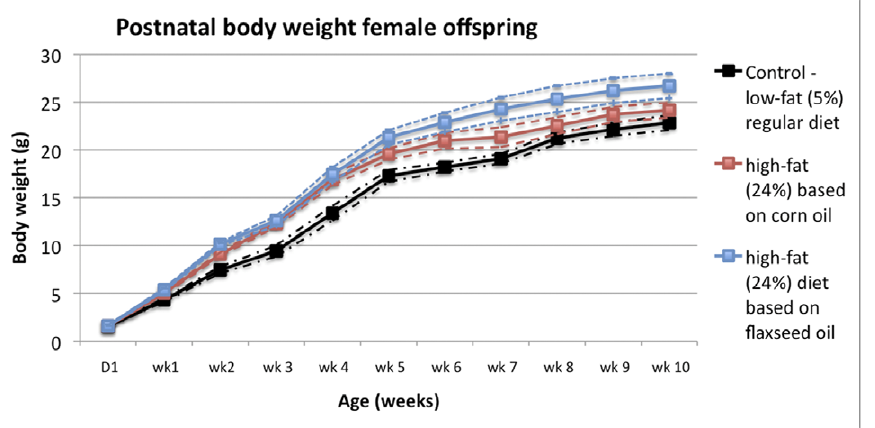
Figure 2. Body weight trajectories in F1 female mice, perinatally exposed to a low-fat (5%) regular mouse diet (indicated in black), or to high-fat (24%) diets based on either corn oil (red) or flaxseed oil (blue). Graph plots mean (and 95% confidence intervals) body weights of F1 female pups with age. The increased body weights of mice fed high-fat diets were significant versus regular diet at 3 weeks of age and beyond ( P , 0.001; nonlinear repeated measures model); however, mice fed the high-fat corn oil diet shifted to the regular trajectory between 6 and 10 weeks of age. The slight dip in the growth curves at 3 weeks of age in all three groups is accounted for by the removal of male pups, which are slightly heavier than